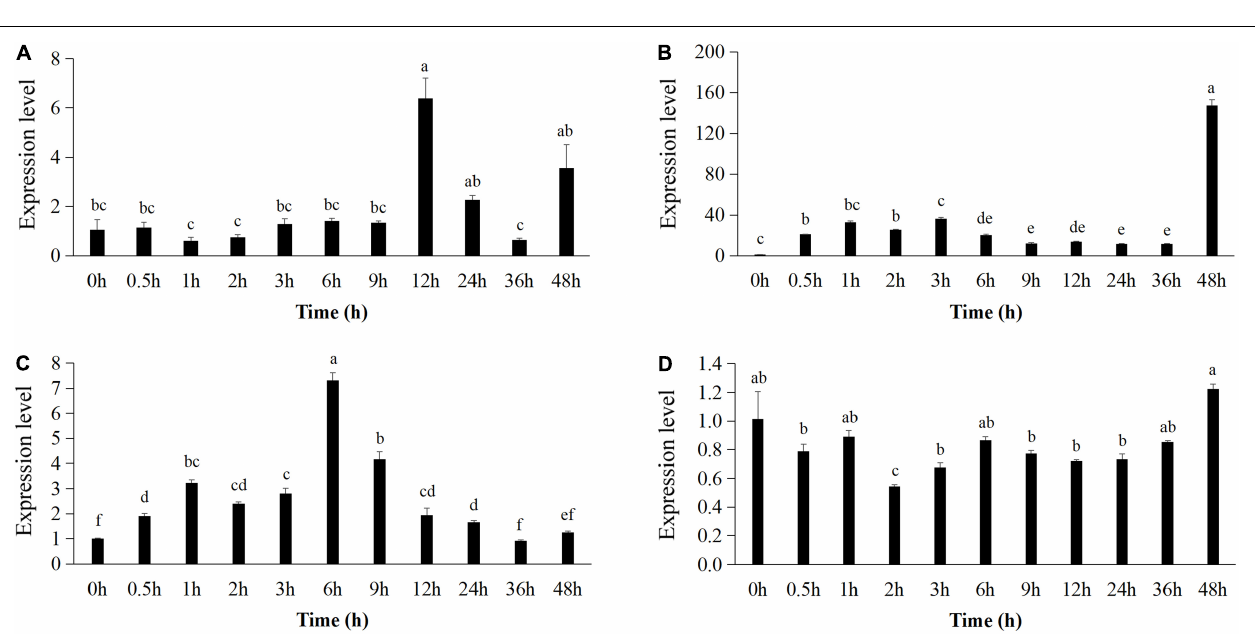
FIGURE 4 | Effect of strain Bv-25 on M. incognita infection in vitro . (A) The number of J2s entered into roots treated with Bv-25 or sterile water. Different letters indicate significant differences ( p < 0.05; n = 30) between treatments according to Duncan multiple-range test following one-way ANOVA. (B–E) J2s in cucumber root treated by Bv-25 (B,C) and sterile water (D,E) . The roots were stained with acid fuchsin. Live nematodes appear bright pink. Scale bars = 50 µ m (C) and 200 µ m.